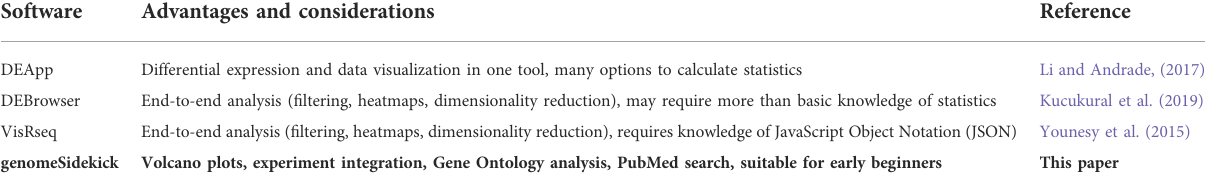
TABLE 1 Example graphical user interfaces for genomics tasks (genomeSidekick in bold).